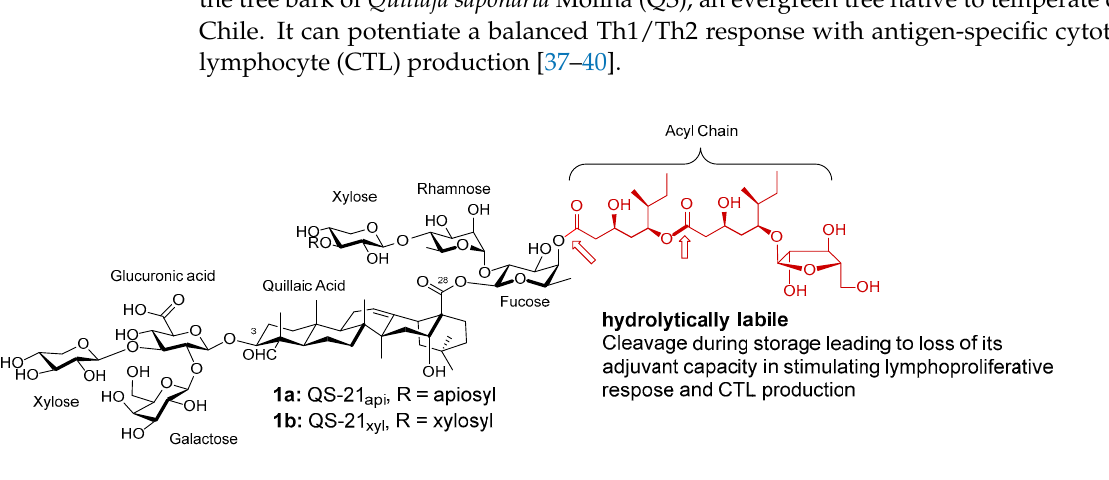
Figure 1. Natural saponin adjuvant QS-21.